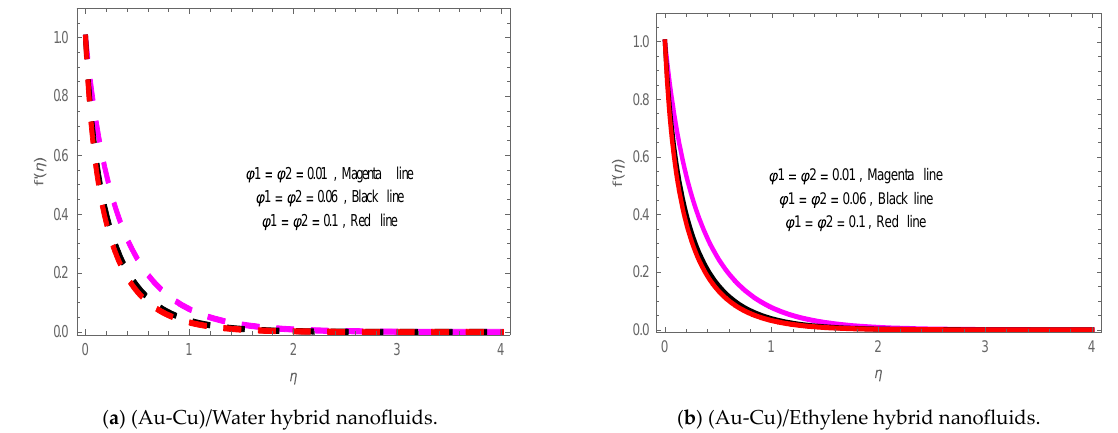
Figure 3. 𝑓 ′ (𝜂) for dissimilar values of 𝜙 1 𝑎𝑛𝑑 𝜙 2 .